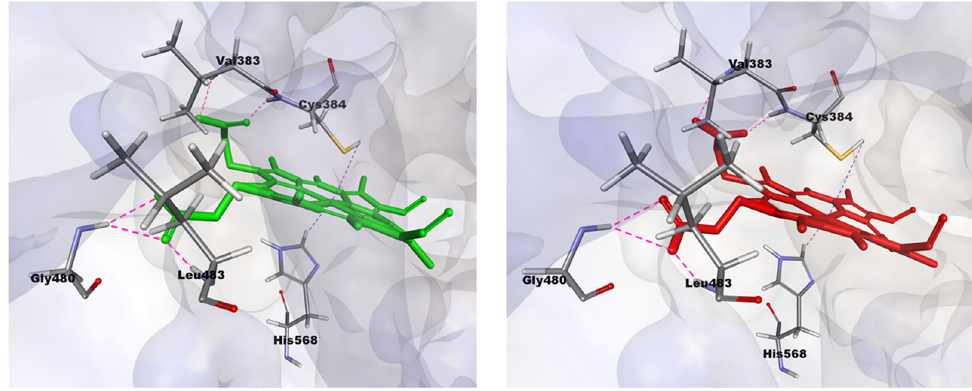
Figure 4. Visualization of interactions occurring in the binding pocket of REV-ERB β when docked against Heme (green) and CoPP (red).